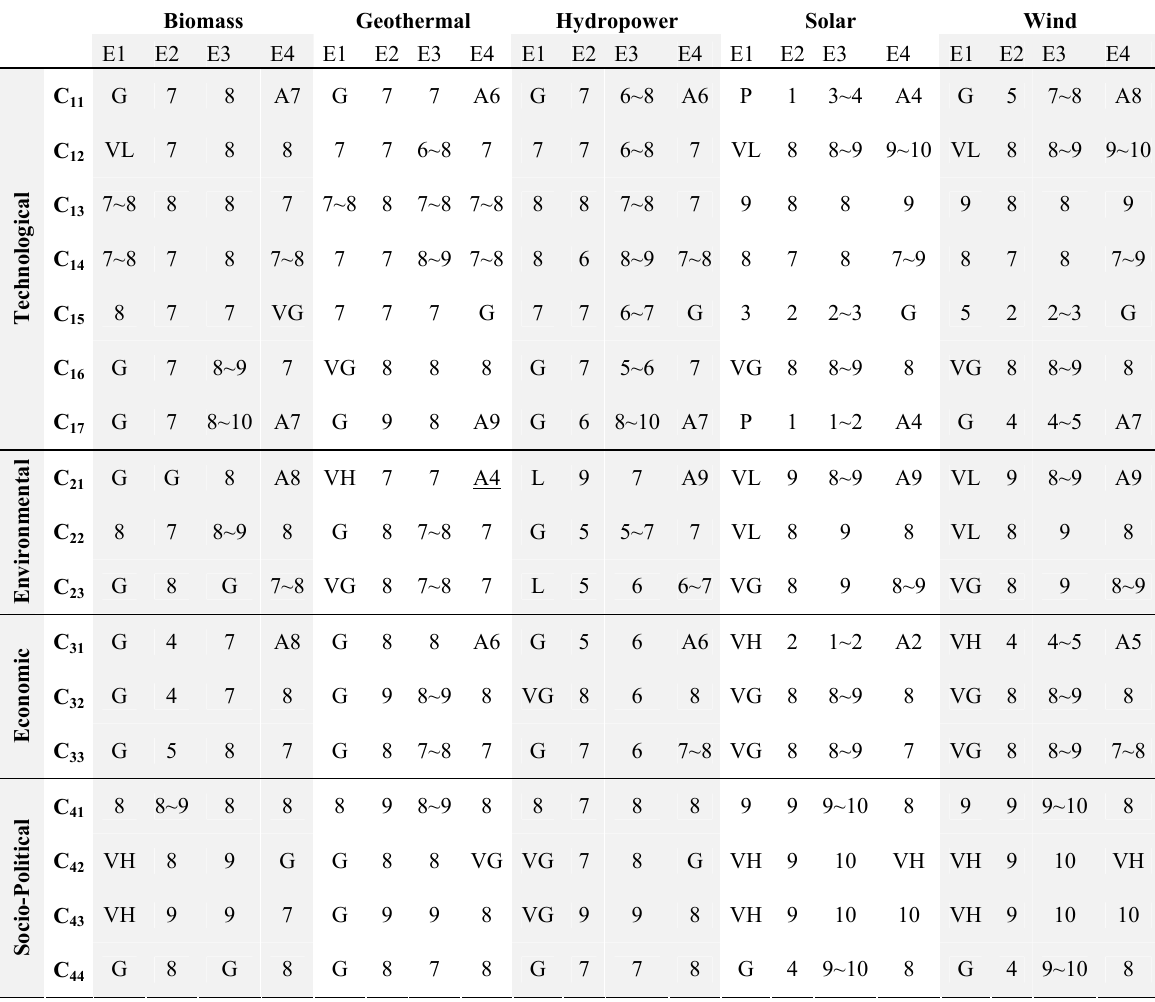
Table 2. Linguistic evaluation for